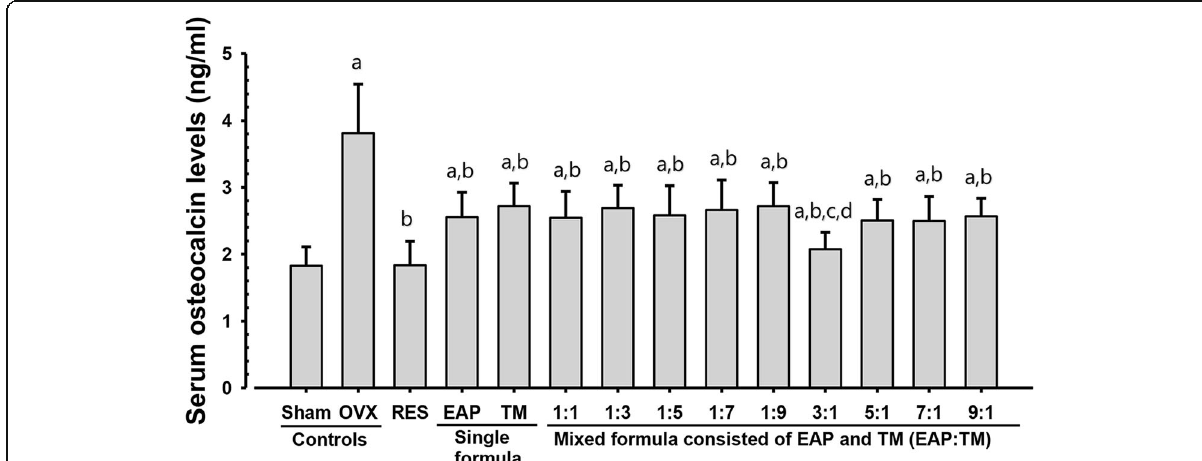
Fig. 2 Serum osteocalcin levels in sham-operated and OVX mice. OVX: Bilateral ovariectomy; RES: Risedronate sodium; EAP: Exopolymers purified from A. pullulans SM2001; TM: T. morbifera leaf extracts; (EAP:TM): Mixed formula consisted of EAP and TM ( g / g ). Values are expressed mean ± S.D. of eight mice. RES was orally administered at a dose level of 2.5 mg/kg. All single and mixed formula consisted of EAP and TM were administered at a dose level of totalized 200 mg/kg by gastric gavage. a p < 0.01 as compared with sham control by LSD test. b p < 0.01 as compared with OVX control by LSD test. c p < 0.05 as compared with EAP single formula treated mice by LSD test. d p < 0.01 as compared with TM single formula